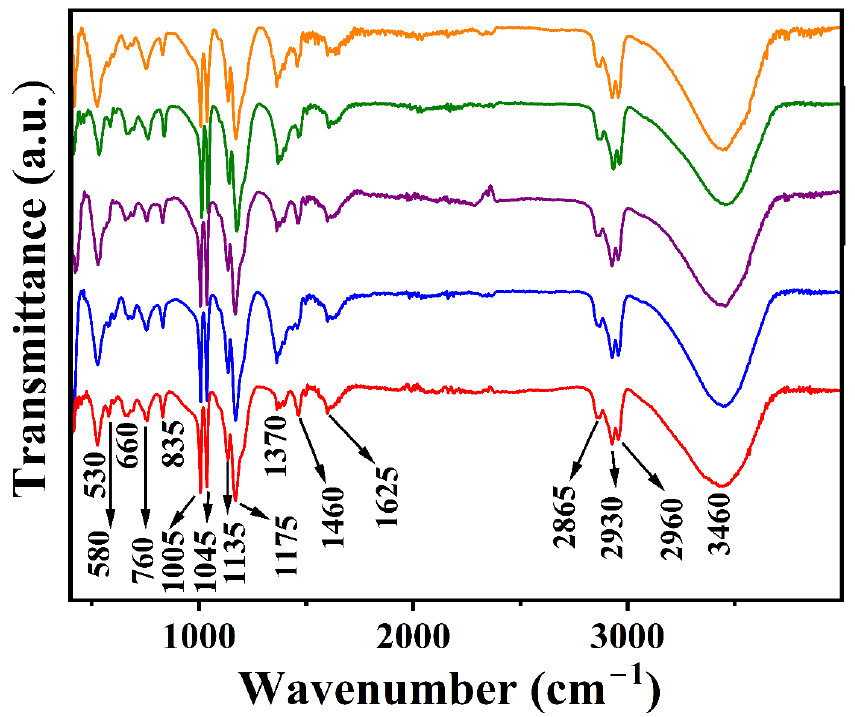
Figure 7. FTIR spectra of Li-M-Al-DBS LDHs (M = Mg (data in red), Co (data in blue), Ni (data in purple), Cu (data in olive green), and Zn (data in orange)).